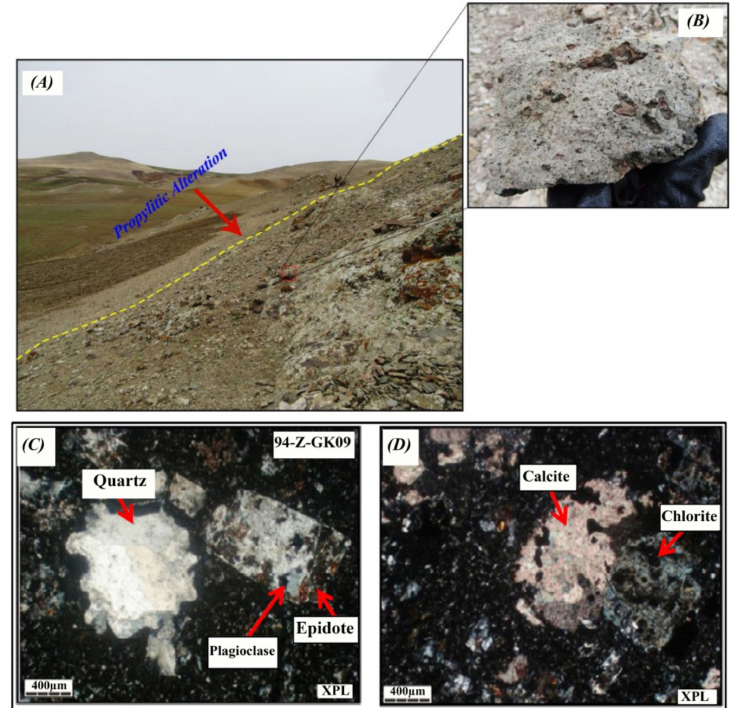
Figure 16. Propylitic alteration zone in the Zailig area. ( A ) View of Propylitic alteration zone; ( B ) Vesicular and amygdaloidal textures in a hand specimen of propylitic zone; ( C ) Microphotographs of plagioclase that is partially replaced by epidote and recrystallized large-grained quartz in the background; ( D ) Microphotographs of amygdaloidal texture in the propylitic zone that amygdales are filled with calcite, chlorite and quartz.